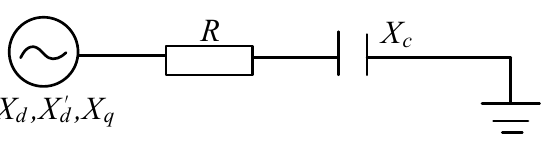
Figure 1. System equivalent circuit.